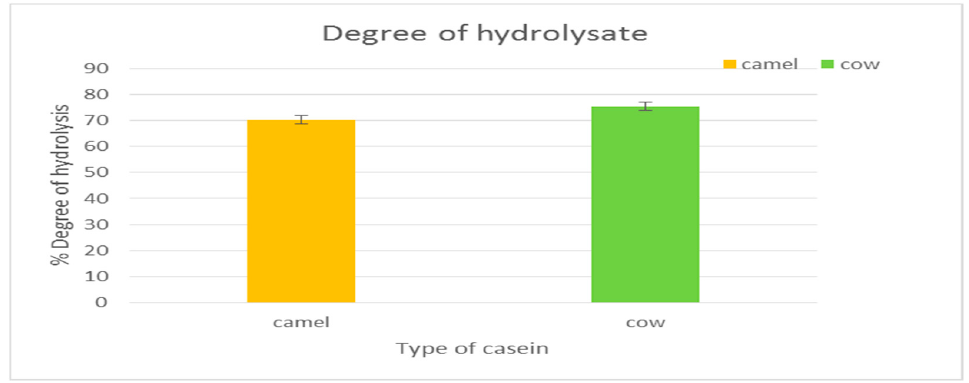
Figure 1. Hydrolysis degree of cow and camel milk casein with trypsin enzyme.